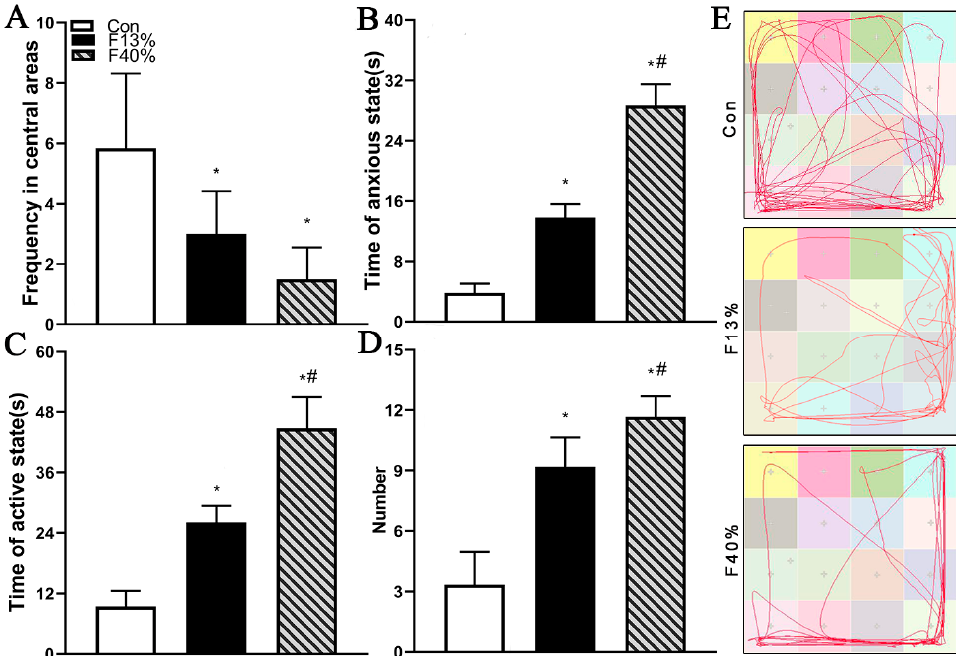
Figure 1. ( A – D ) Frequency in central areas ( A ), duration of anxious state ( B ), duration of active state ( C ), and number of standing ( D ) of animals in three groups. ( E ) The representative trajectories of animals in three groups. Note: Con means control group; F13% means 13% fructose group; F40% means 40% fructose; in every group, n = 6. Each bar represents mean ± SEM. * p < 0.05 (vs. control group); # p < 0.05 (vs. 13% fructose).